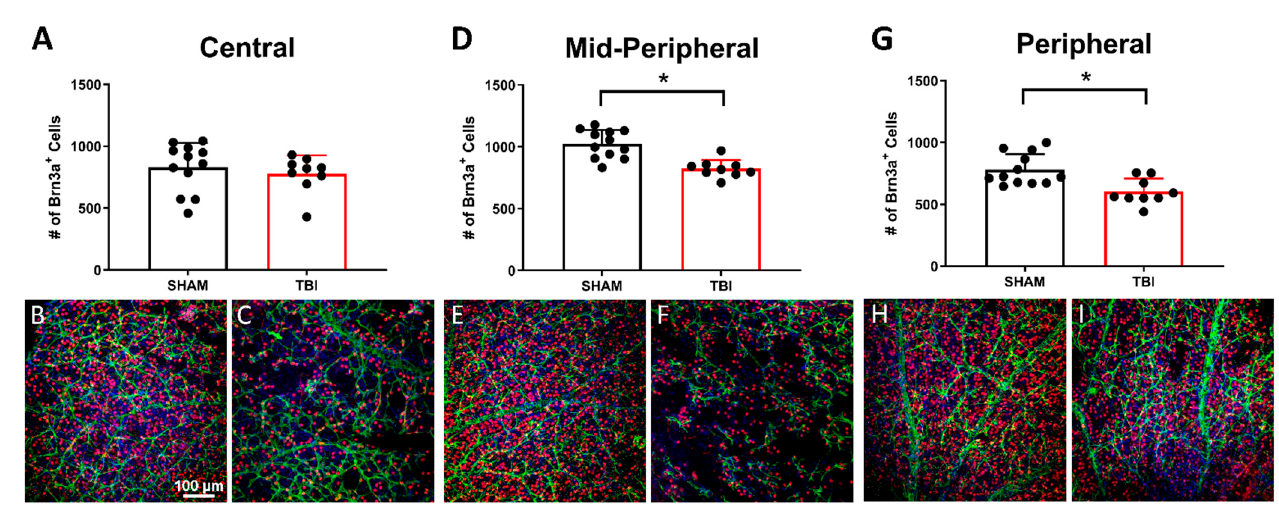
Figure 6. Retinal ganglion cell counts at 30 DPI. Retinas of sham and TBI mice were labeled with Brn3a (red), GFAP (green), and DAPI (blue). Cell count results are shown for center ( A ), mid-peripheral ( D ), and peripheral ( G ). Representative photomicrographs taken at 20 × magnification of sham ( B , E , H ) and TBI/iTON mice ( C , F , I ). Scale bar indicates 100 µ m and is the same for all images, * p < 0.001.